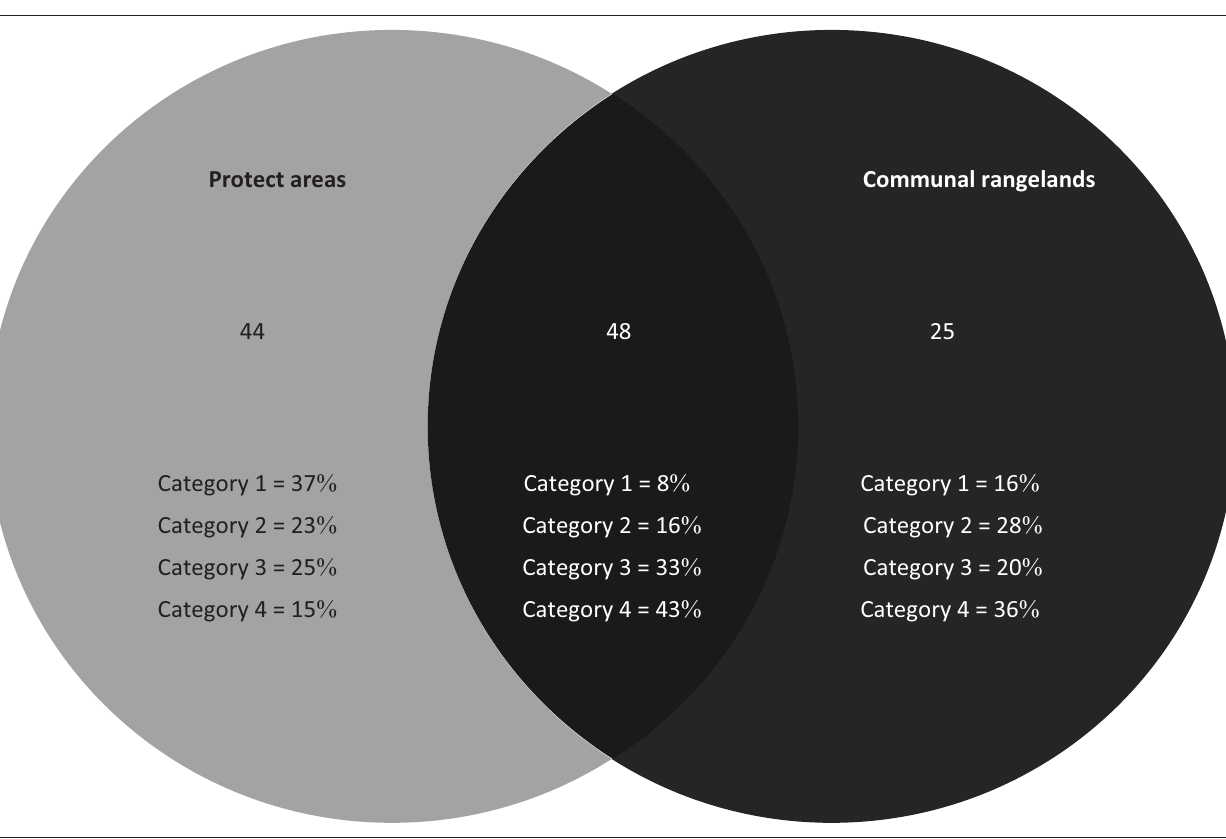
FIGURE 3: Venn diagram showing the number of bird species that are shared and are unique to protected areas and communal rangelands. Additionally, the percentage of birds in each habitat preference category is shown for each land-use type. Category 1 = birds that associate with open grassy areas; category 2 = birds that associate with open grassy and closed-canopy wooded areas, but have a greater affinity for open grassy areas; category 3 = birds that associate with open grassy areas and closed- canopy wooded areas, but have a greater affinity for closed-canopy wooded areas and category 4 = birds that associate with closed-canopy wooded